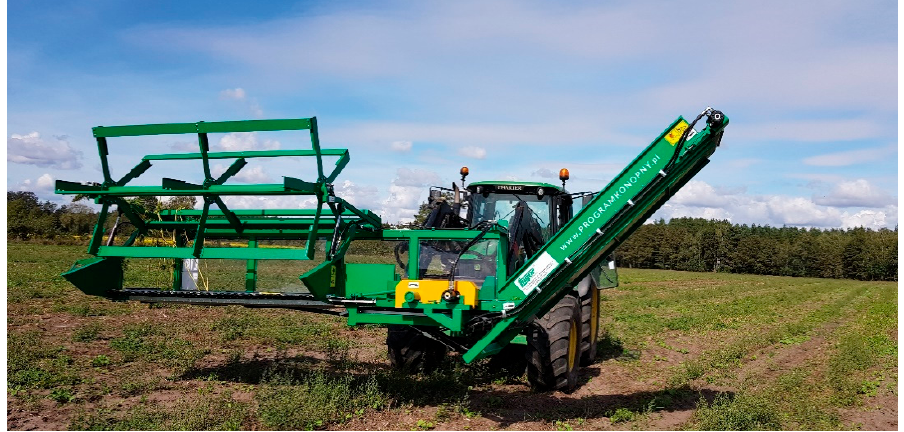
Figure 2. Vision of the